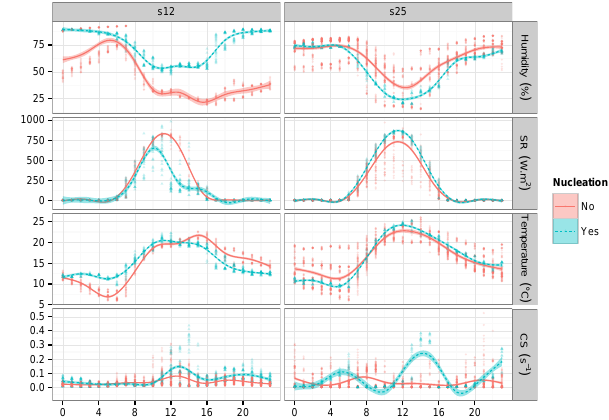
Figure 1. Average diurnal pattern of solar radiation (SR), humidity, temperature and condensation sink (CS) as well as the measured data on nucleation and non-nucleation day at s12 and s25. Shaded areas represent the 95% confidence interval in the mean. Data in- clude 5 and 51 nucleation and non-nucleation days respectively.